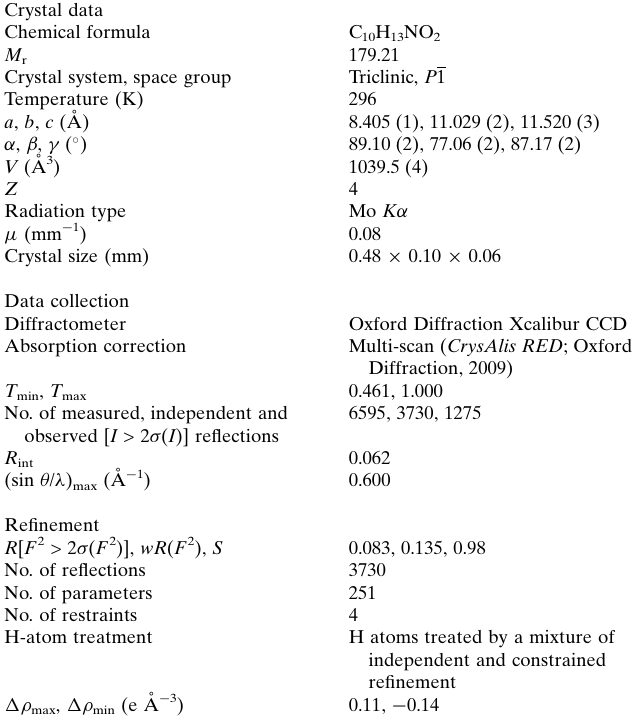
Table 2 Experimental details. Crystal data Chemical formula